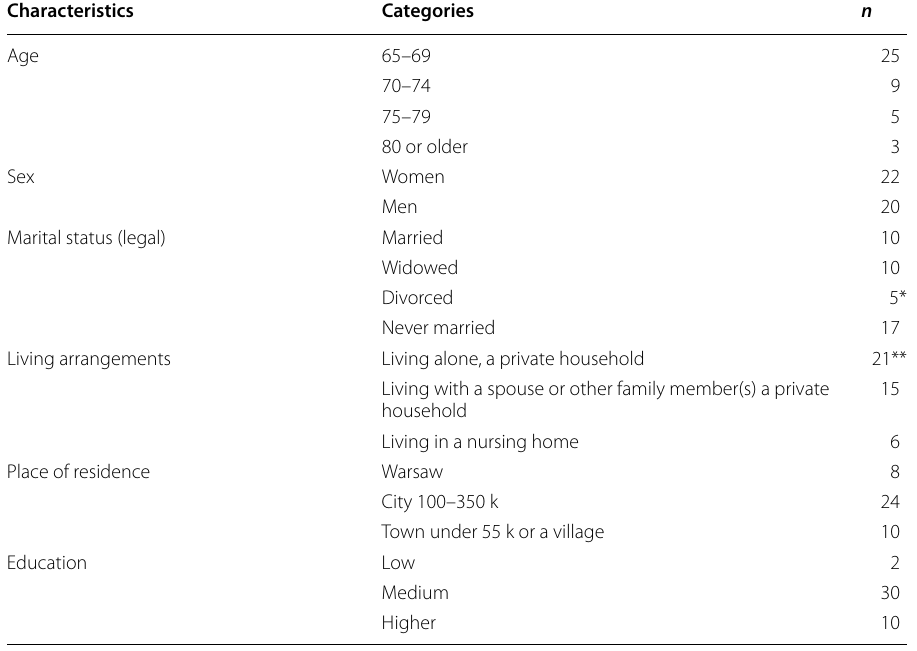
Table 1 Socio‑demographic data of the participants, n